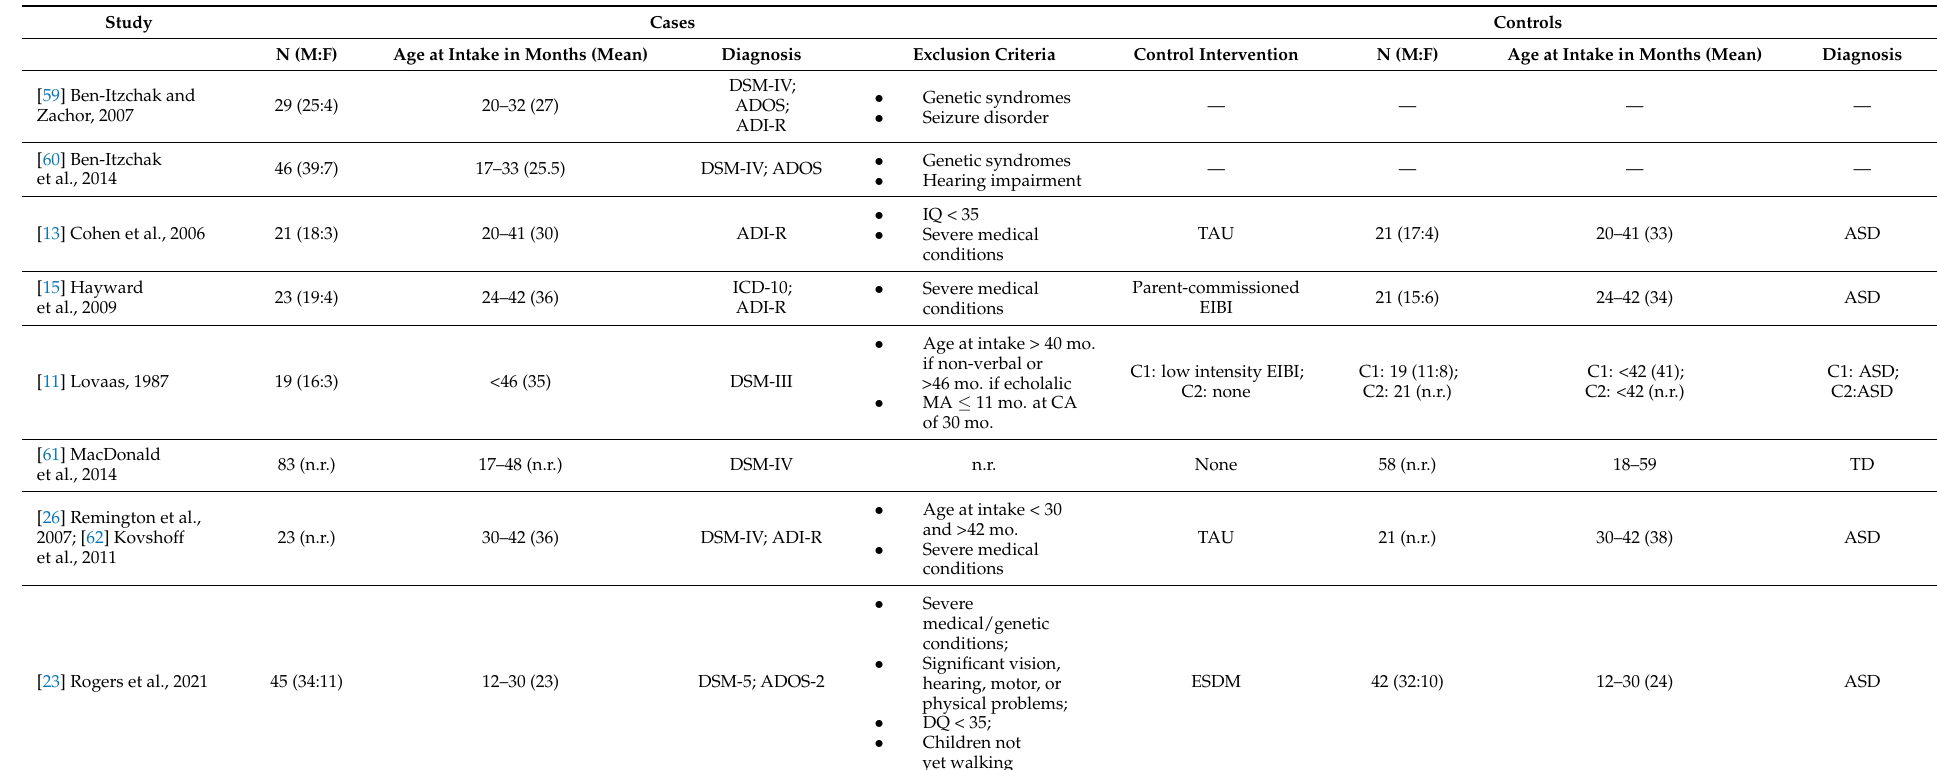
Table 1. Summary of EIBI studies: sample